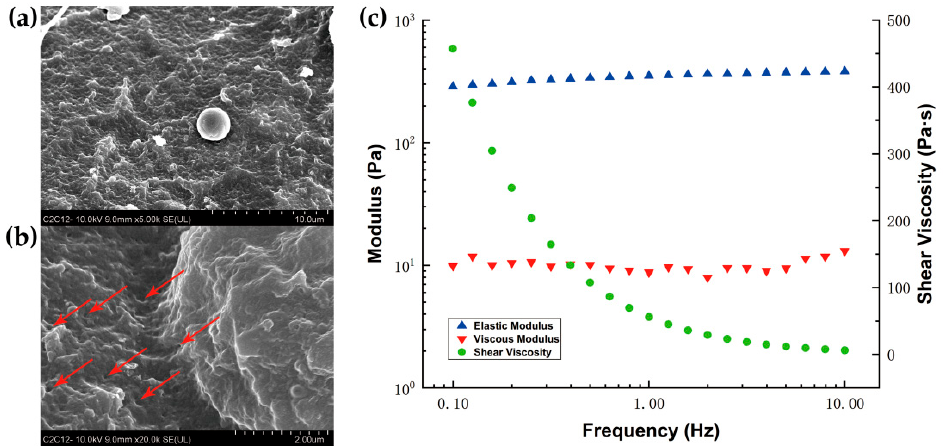
Figure 3. SEM images and viscoelasticity of the 3D homogenous dextran hydrogels. The main parameters of dextran hydrogel were crosslinking strength = 2 mM and RGD = 300 µM; ( a ) Image of 3D dextran hydrogel with 5000 times magnification under SEM; ( b ) Image of 3D dextran hydrogel with 20,000 times magnification under SEM; ( c ) The elastic modulus (G ′ ), viscous modulus (G ′′ ), and shear viscosity (complex component) of dextran hydrogel.